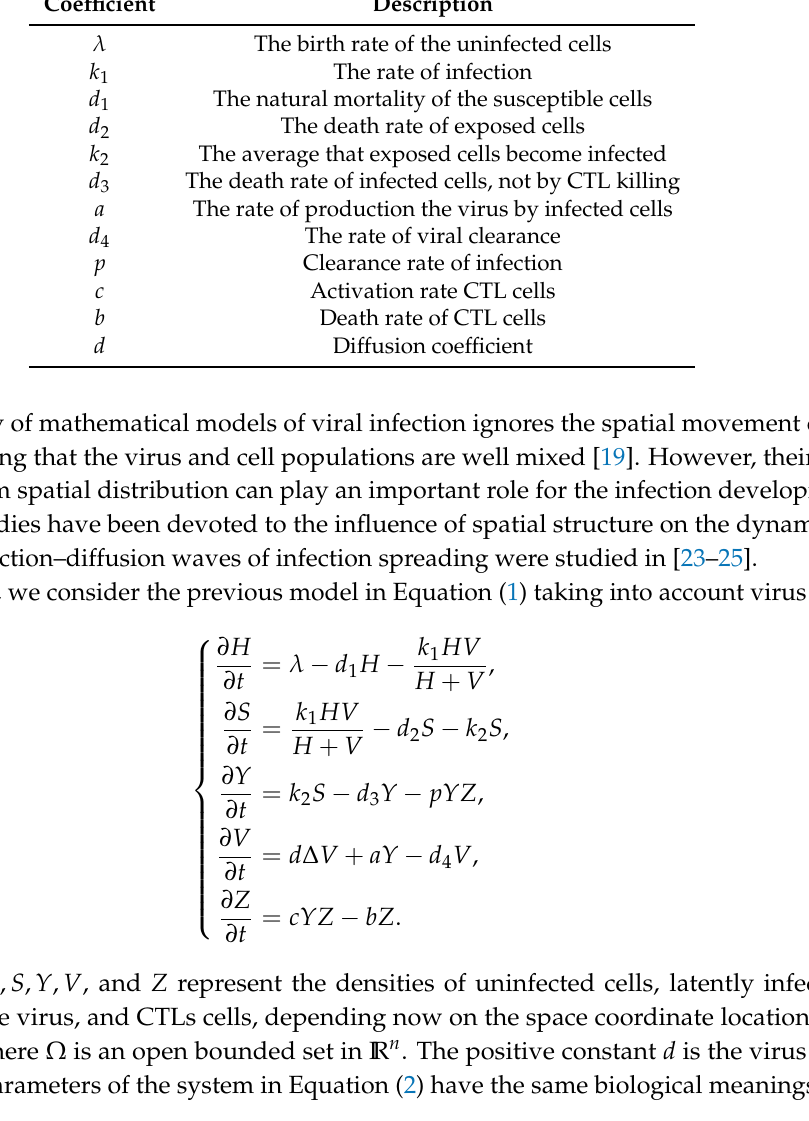
Table 1. The parameters of the mathematical model and their descriptions. Coefficient Description λ The birth rate of the uninfected cells k 1 The rate of infection The natural mortality of the susceptible